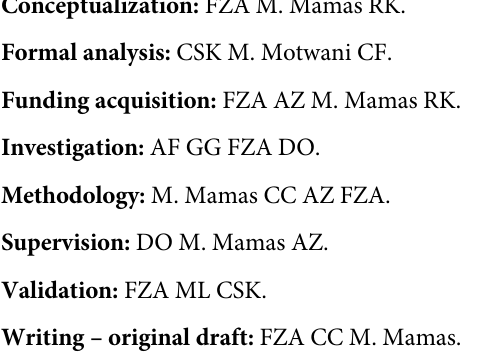
S1 Table. Effect of global longitudinal strain < 14.5 compared to > 14.5 on risk of decline in LVEF (cid:21) 5% at 12 months according to level of